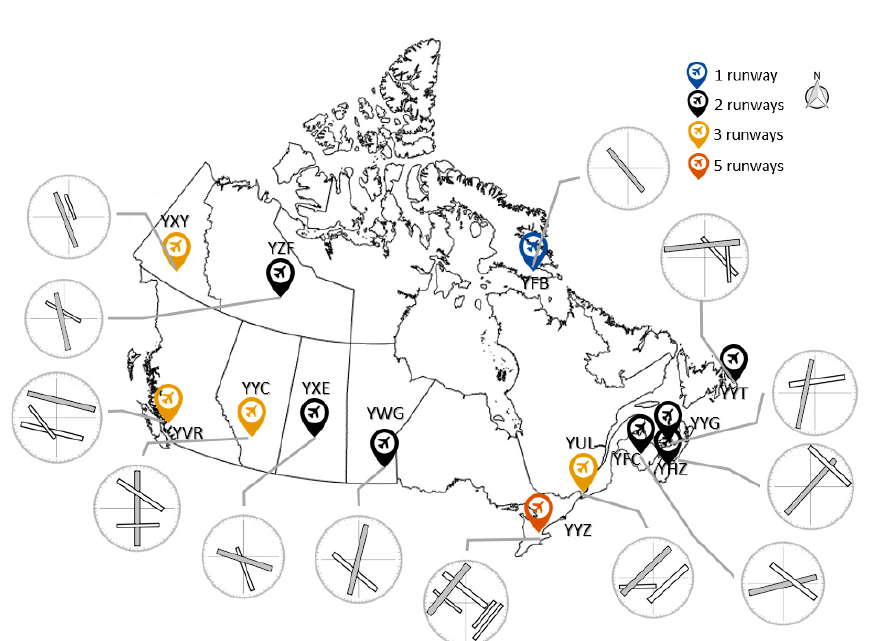
Figure 1. ( a ) Model experimental domain consisting of 172 × 172 grid points; every fifth grid point is shown. The region of analysis (Canada) considered in this study has topography shown in color. ( b ) Runways and their orientations for the 13 airfields considered in this study. The longest runway at each airport is shown shaded. The colors indicate the number of runways (see legend).